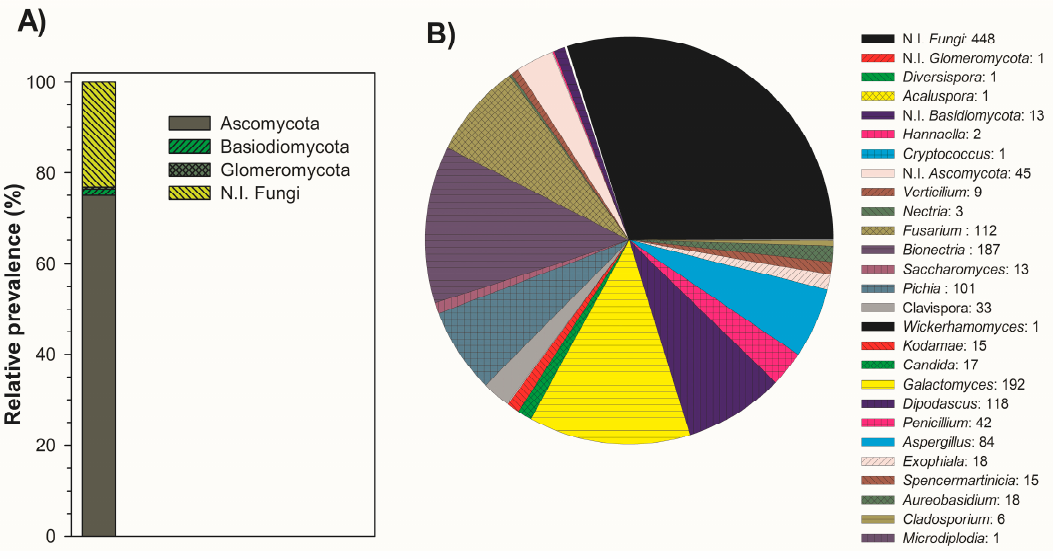
Figure 2. Relative abundance at the phylum level and counts of filamentous fungi and yeasts in fermented sotol ( Dasylirion sp.) must. ( A ) Microbial groups with relative prevalence. ( B ) Filamentous fungi and yeast diversity: number of strains.